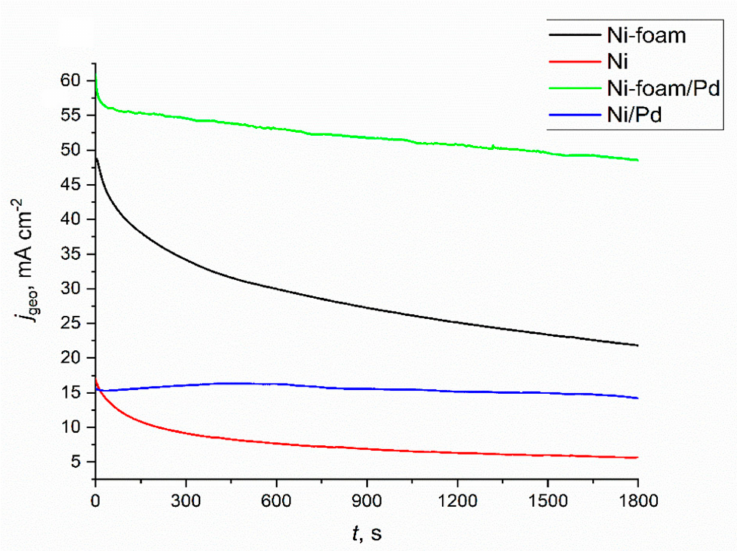
Figure 15. Chronoamperometric measurements in 1 M NaOH + 1 M ethanol addition for flat and porous Ni samples with and without the surface modification with Pd 2+ ions. Modification time: 3600 s. Applied potential: 1.6